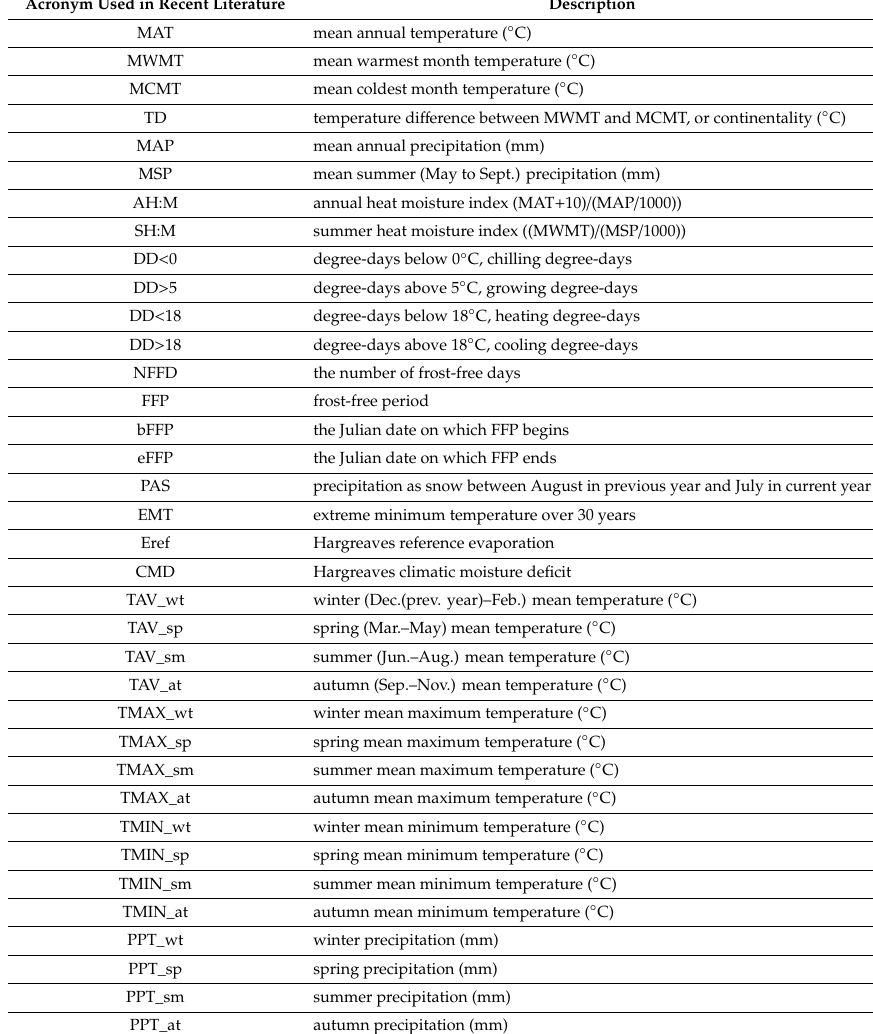
Table 4. Full list of the 36 climatic variables calculated for the hierarchical clustering and future scenarios forecasting step. All variableswere calculated according to Wang et al. [52] from raw values obtained by KNMI Climate Explorer and used as predictors in the Generalized Additive Mixed Models